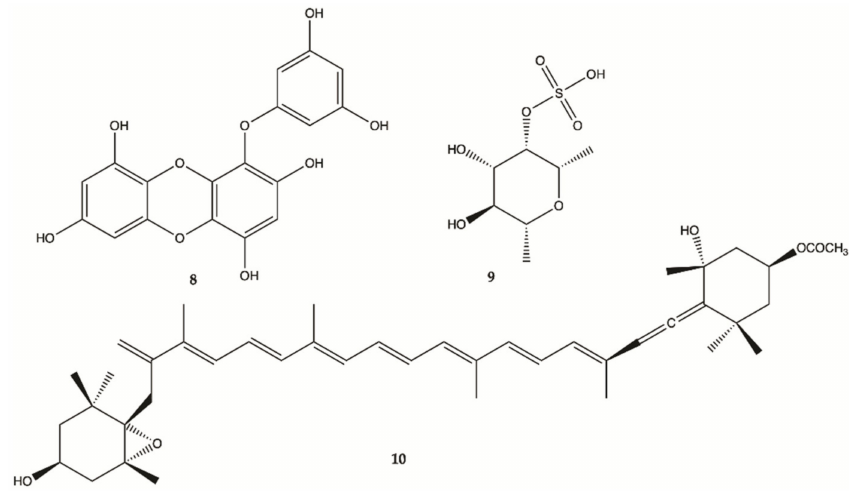
Figure 5. Compounds 8 – 10 isolated from brown seaweed